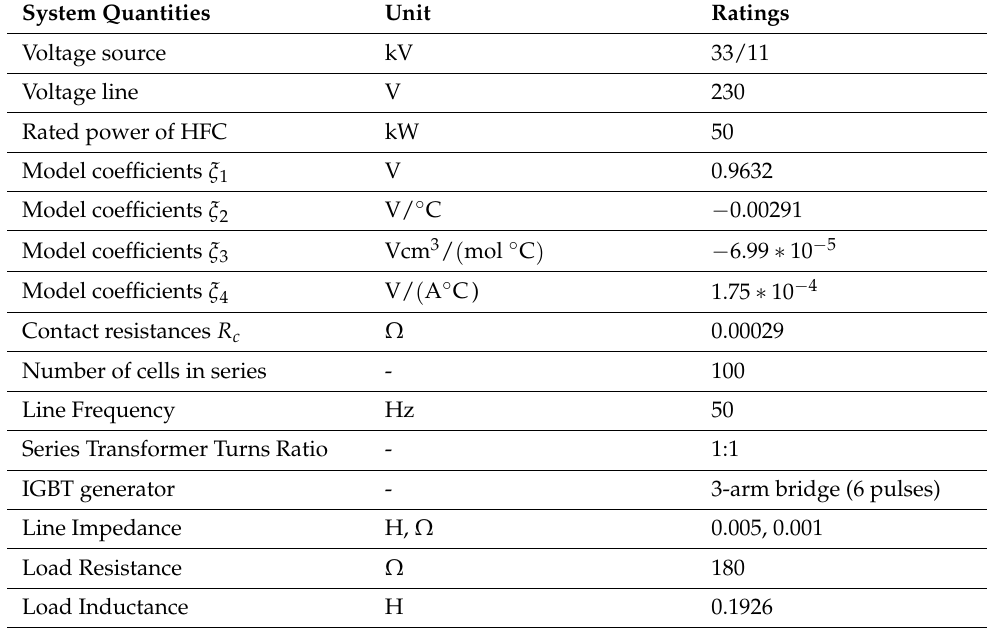
Table 3. Simulation parameters of DNS and HFC